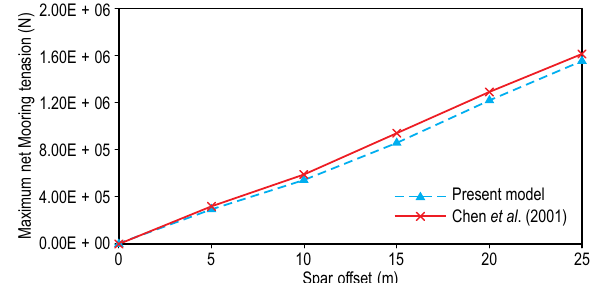
Fig. 3. Assessment of present model output with experimental result